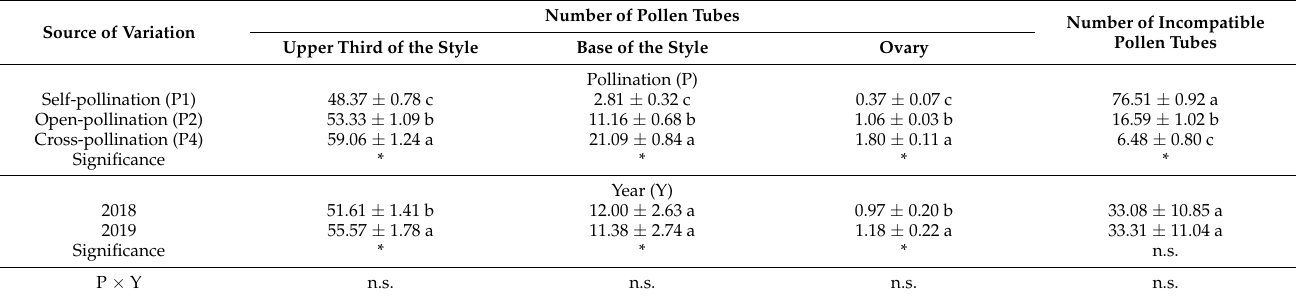
Table 1. Significance of the effects of the pollination treatment (self-, cross-, and open-pollination), the year (2018–2019) and the pollination × year interaction (assessed with two-way ANOVA) on the number of pollen tubes—found in the sections of the upper third and the base of the pistil styles and of the ovary—and the number of incompatible pollen tubes in ‘Satluj Purple’ trees. Measurements were carried out 240 h after the application of the pollination treatments. Within each column and separately for the source of variation (pollination and year), mean values followed by the different letters represent significant differences ( p < 0.05) according to Tukey’s HSD